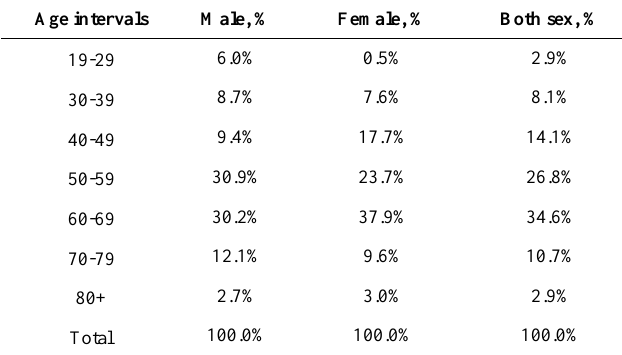
Table 1. Distribution of patients by age at 1 st PET-CT and sex